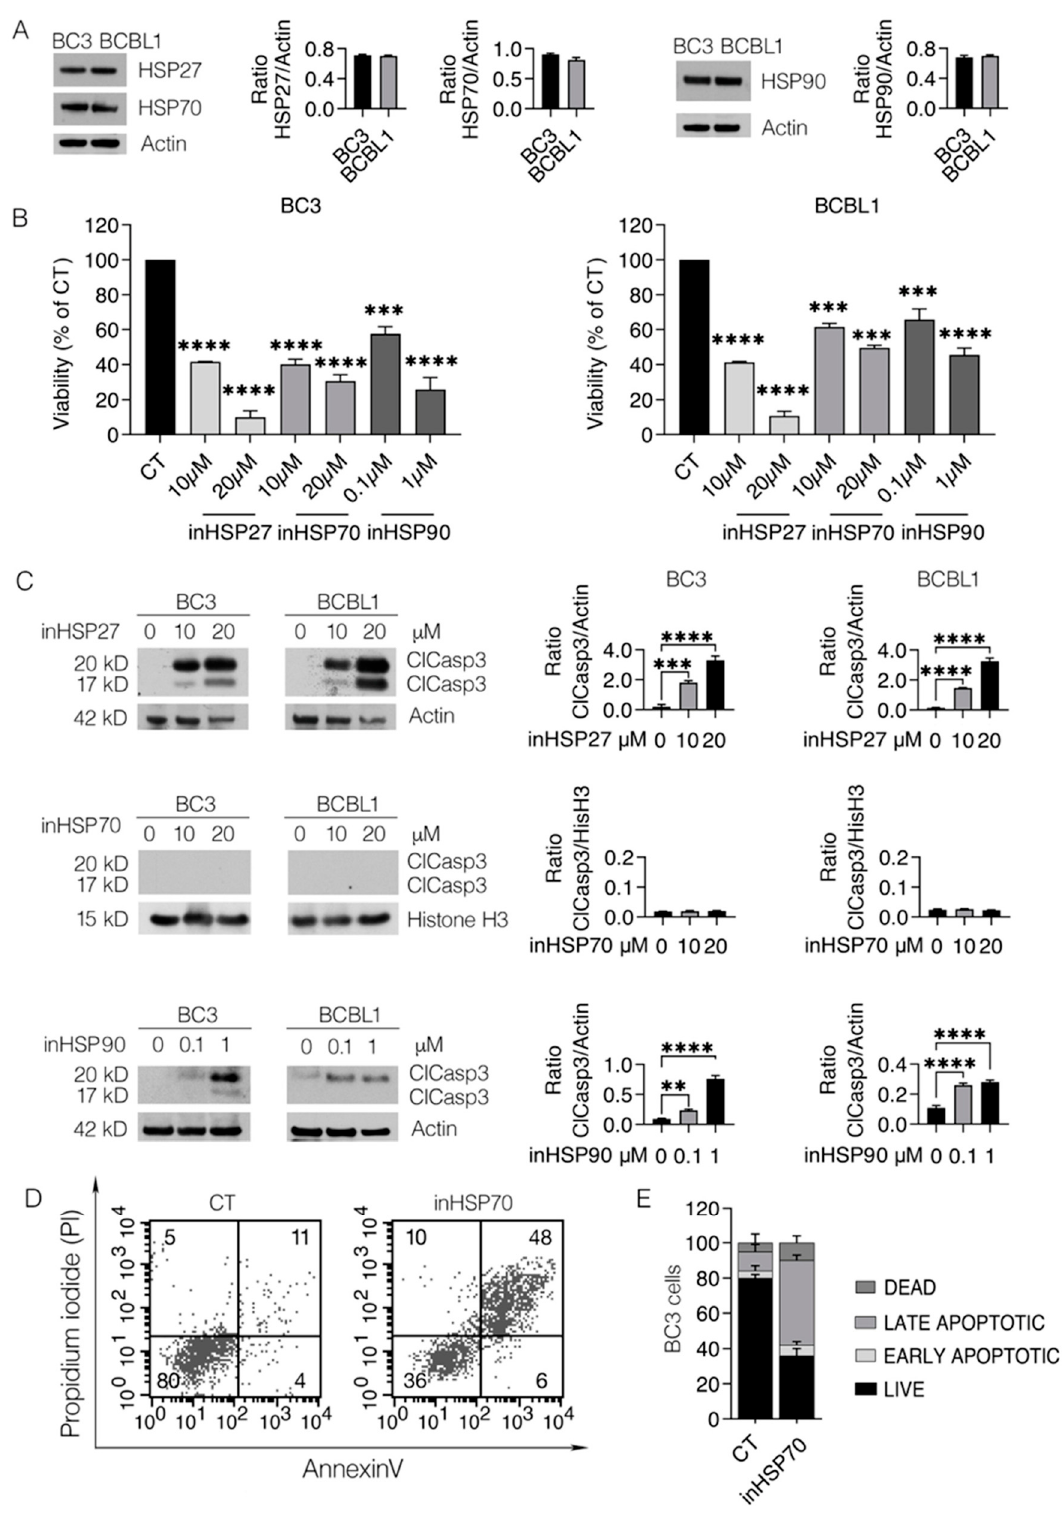
Figure 1. Inhibitors of HSPs strongly impair PEL survival. ( A ) Protein expression levels of HSP27, HSP70 and HSP90 were evaluated by Western blot analysis in BC3 and BCBL1. Actin was used as a loading control and one representative experiment is shown. The histograms represent the densitometric analysis of the ratio of specific protein/actin. Data are represented as the mean plus S.D. BC3 and BCBL1 cells were treated with inHSP27 (J2) (10–20 µ M), inHSP70 (PES) (10–20 µ M) or inHSP90 (17AAG) (0.1–1 µ M) for 24 h and ( B ) cell survival was evaluated by a trypan blue